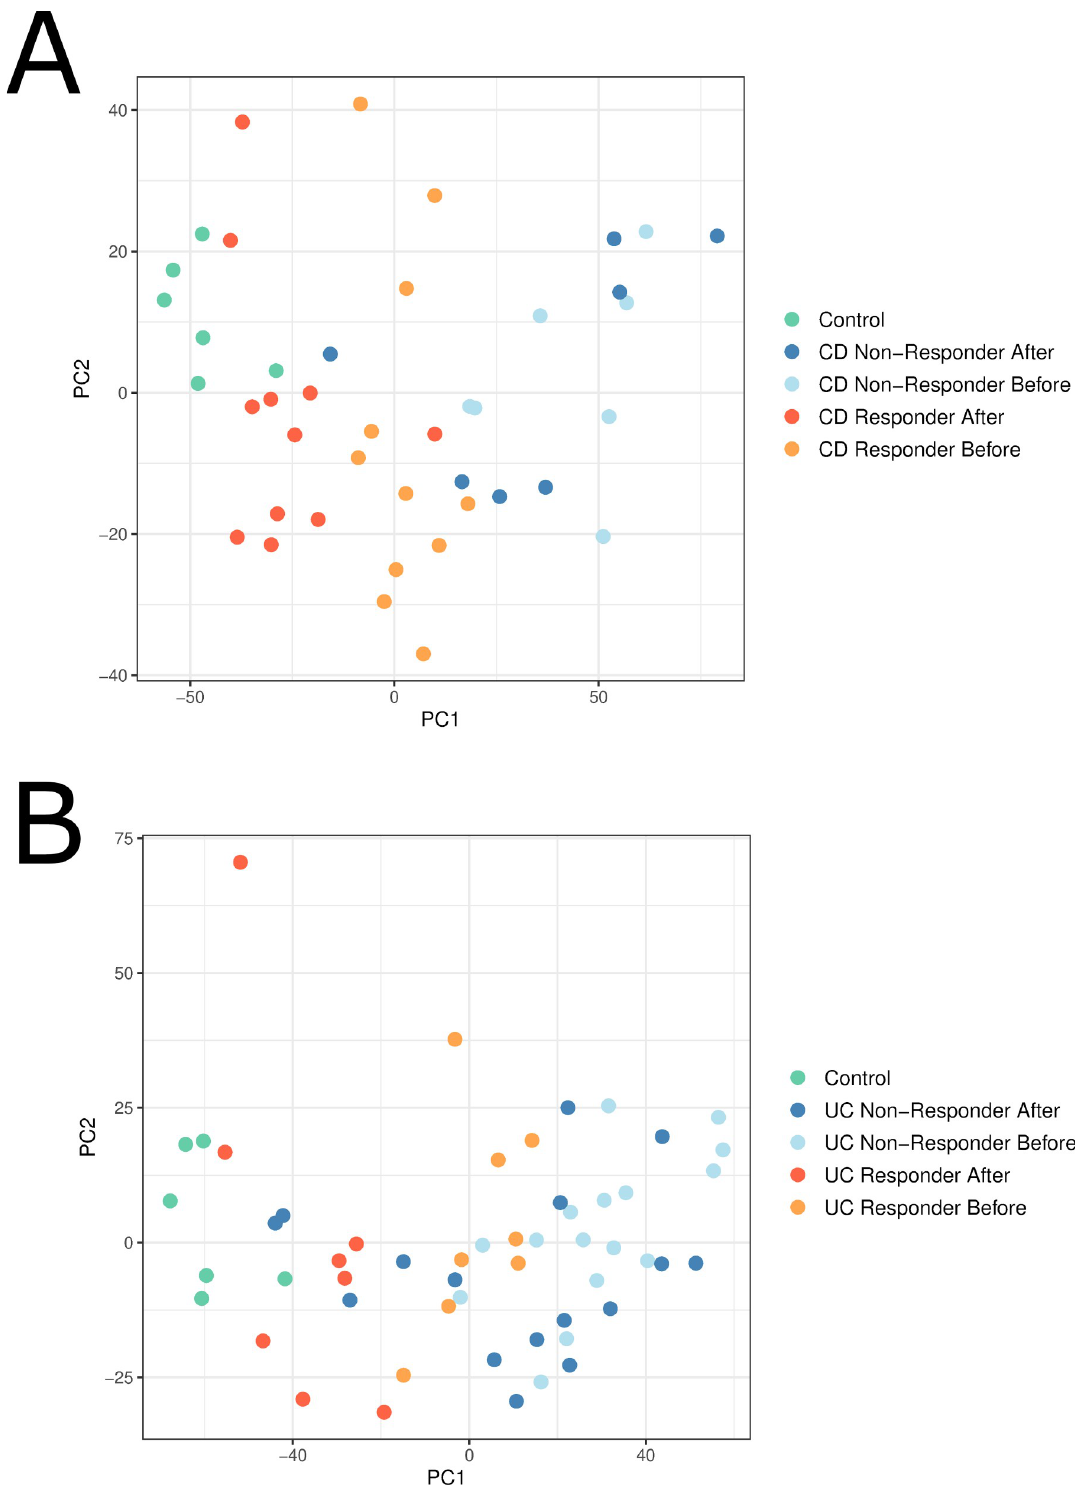
Fig 3. Principal components analysis showing drug responders and nonresponders before and after infliximab treatment in patients with CD (A) and UC (B) from GSE16879. Responder samples after treatment appear to migrate towards the control healthy samples.